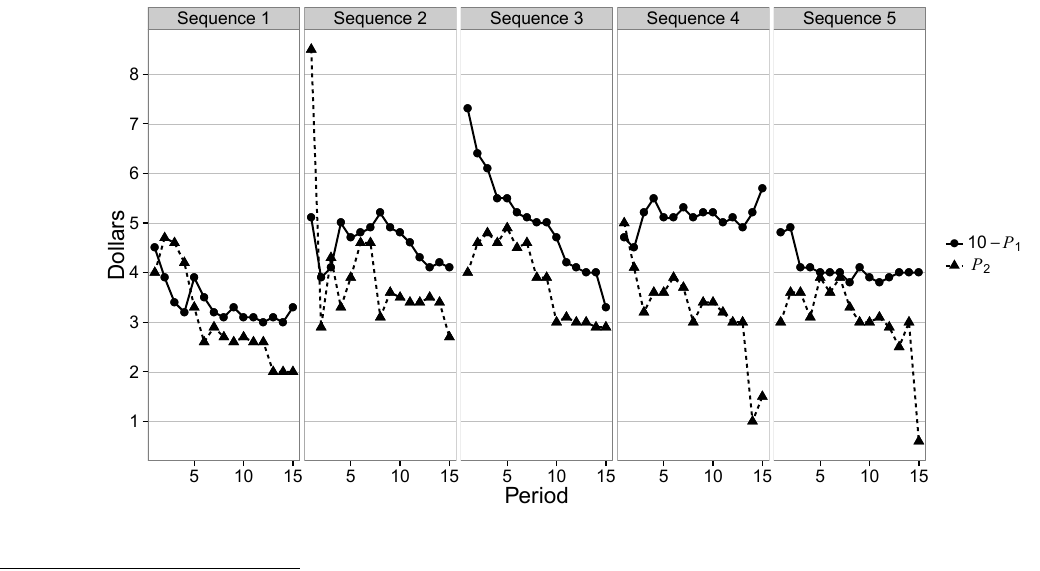
and P for the Five Price 1 2